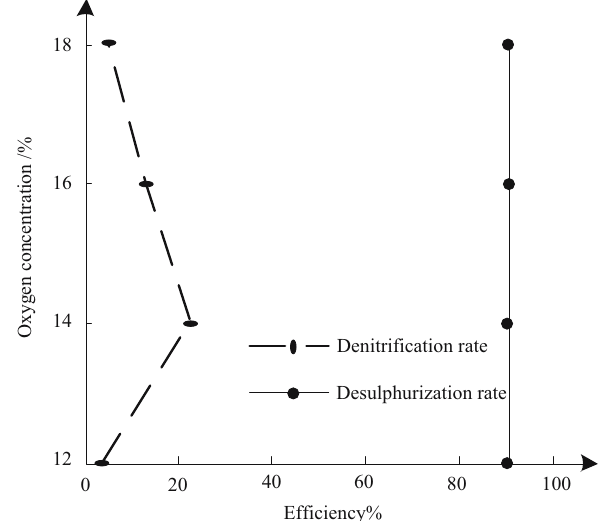
Figure 4: E ff ect of oxygen concentration on desulfurization and de - nitri fi cation of sintering fl ue